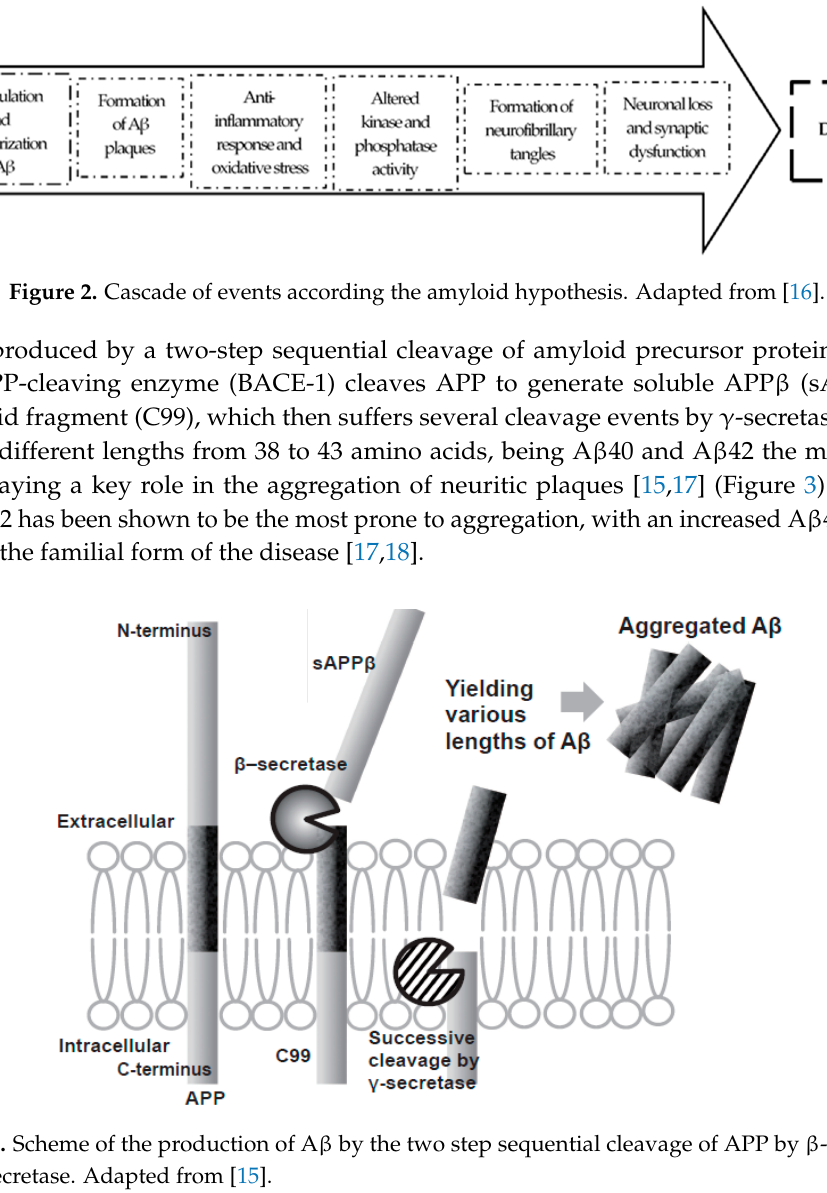
Figure 2. Cascade of events according the amyloid hypothesis. Adapted from [16].